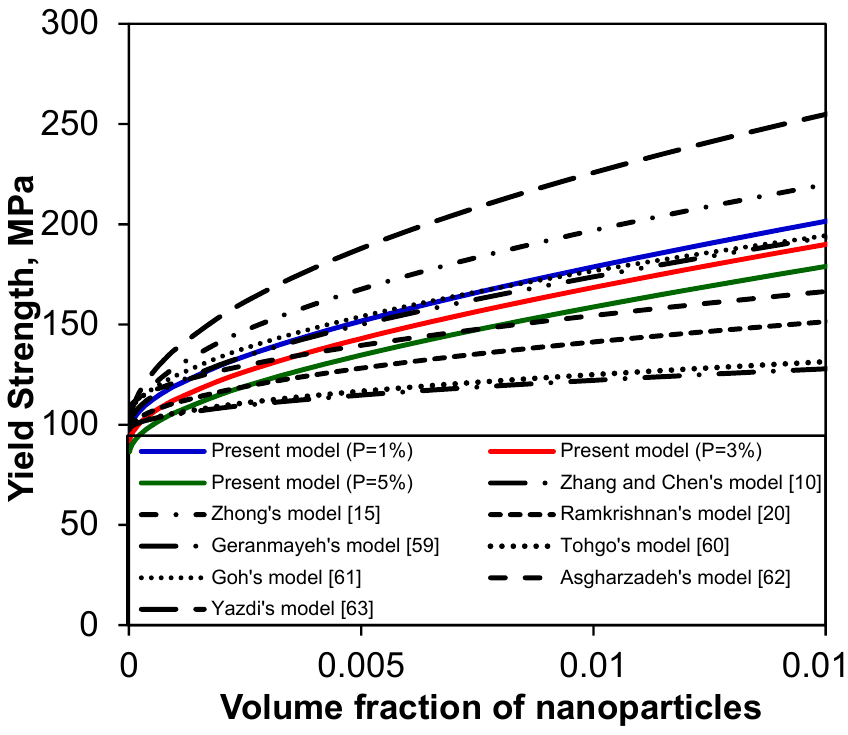
Figure 4. Comparison of the present model with different models reported